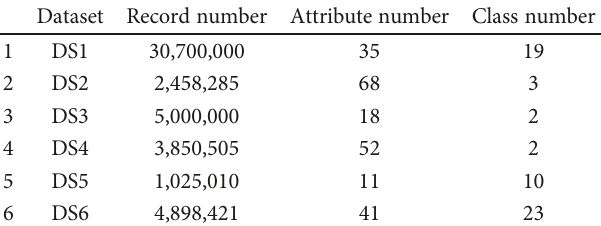
Algorithm 5: Table 2: Datasets. Table 3: Reduction results of the two algorithms. Dataset